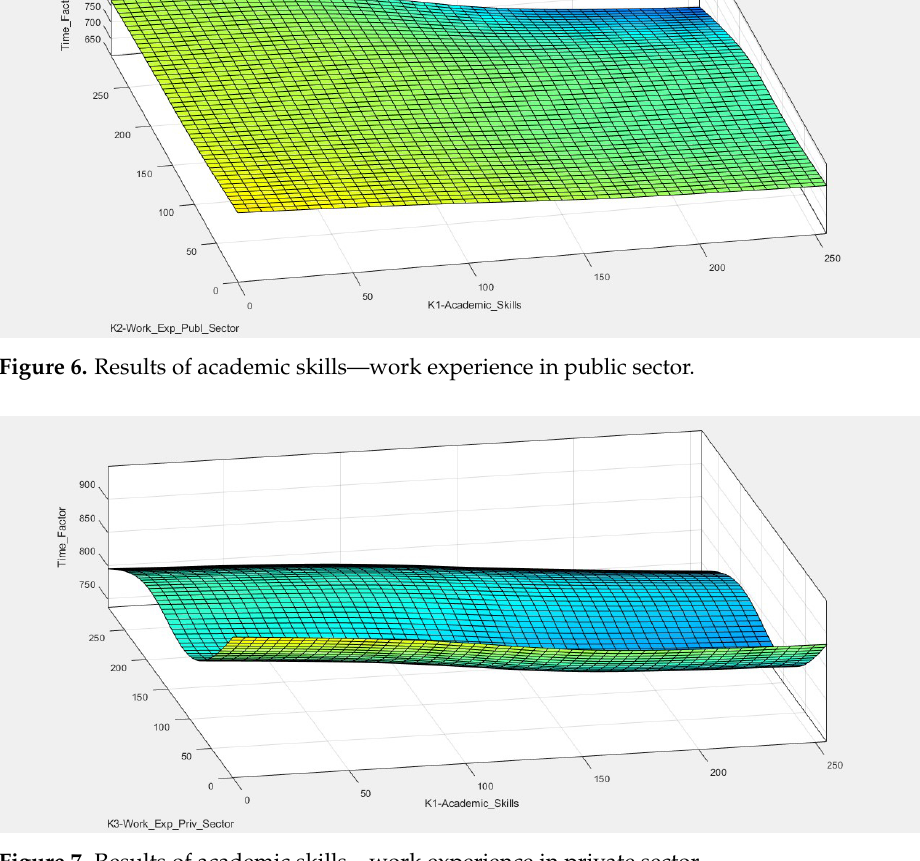
Figure 7. Results of academic skills—work experience in private sector.